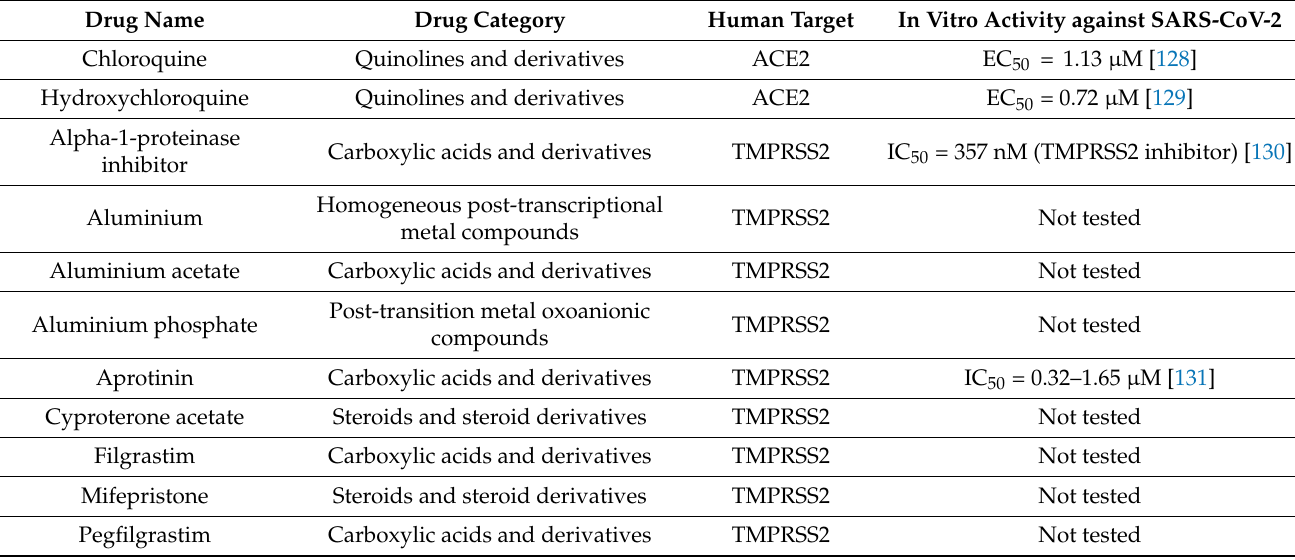
Table 3. Potential anti-SARS-CoV-2 drugs and predictive targets identified in this